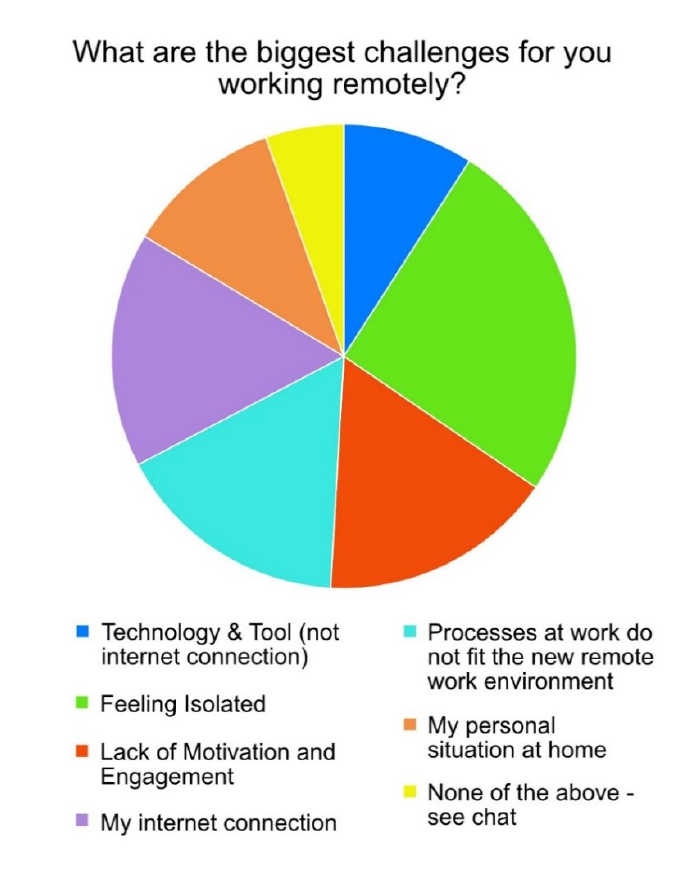
FIGURE 2. WHAT ARE THE BIGGEST CHALLENGES FOR YOU WORKING